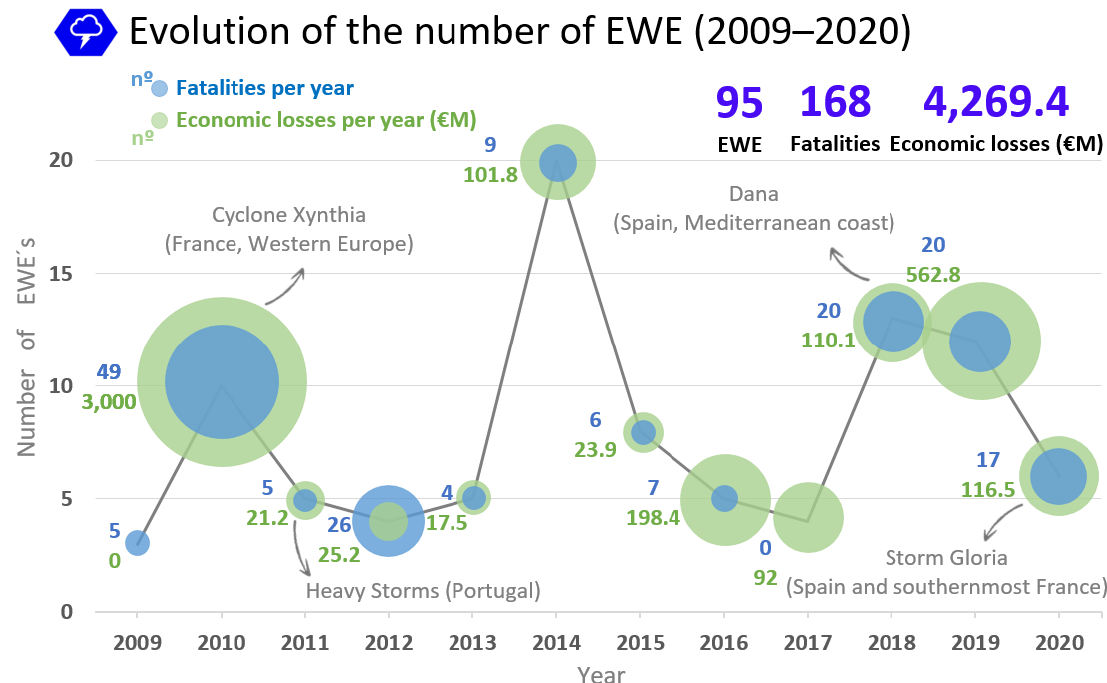
Figure 6. Annual distribution of the number of extreme weather events (EWE), fatalities, and economic damage for the study period (2009 – 2020). For 2020, only the months of January and February were analysed.